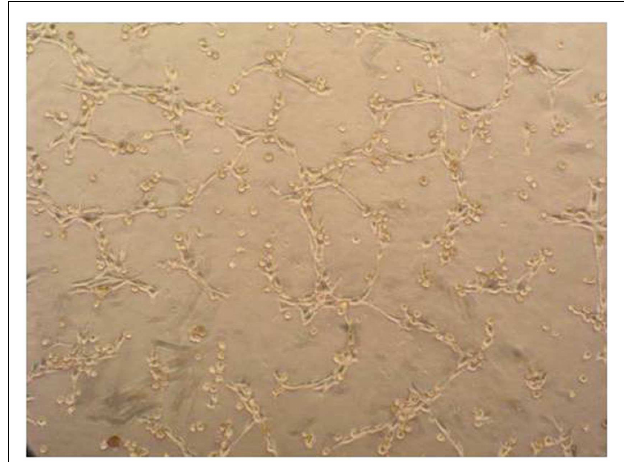
FIGURE 2 | Phase contrast photomicrograph of normal melanocytes growing on a layer of Matrigel